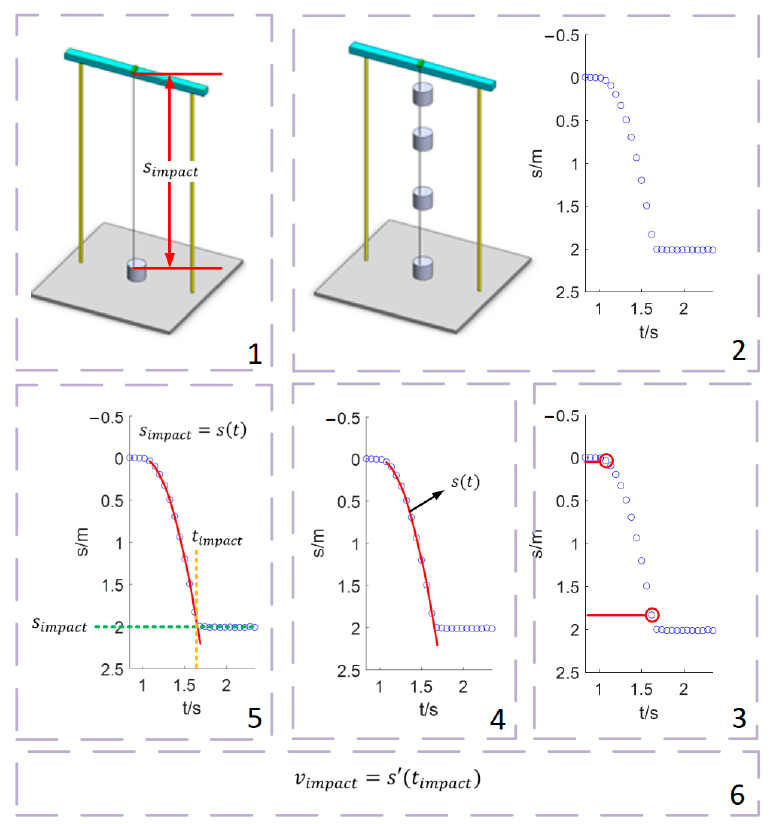
Figure 3. Specific steps of TPMM. 1. Impact position measurement; 2. Falling trajectory measurement; 3. Data identification of free-falling stage; 4. Falling trajectory expression fitting; 5. Impact time calculation; 6. Impact velocity